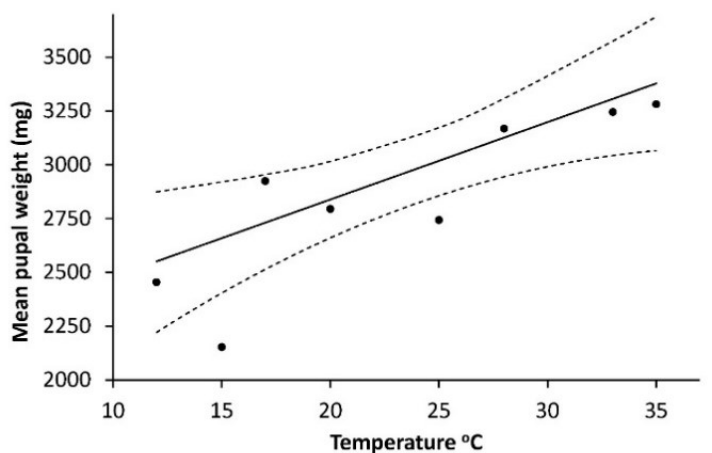
Figure 4. Pupal weight of Agrotis segetum as function of temperature. Pupal weight (mg) = 2119.423 + 35.956 T. R 2 = 0.688, F = 13.25, p = 0.011. Both sexes are involved, as no statistical difference was found between the two sexes. Therefore, sex was removed from the final model. The dashed lines above and